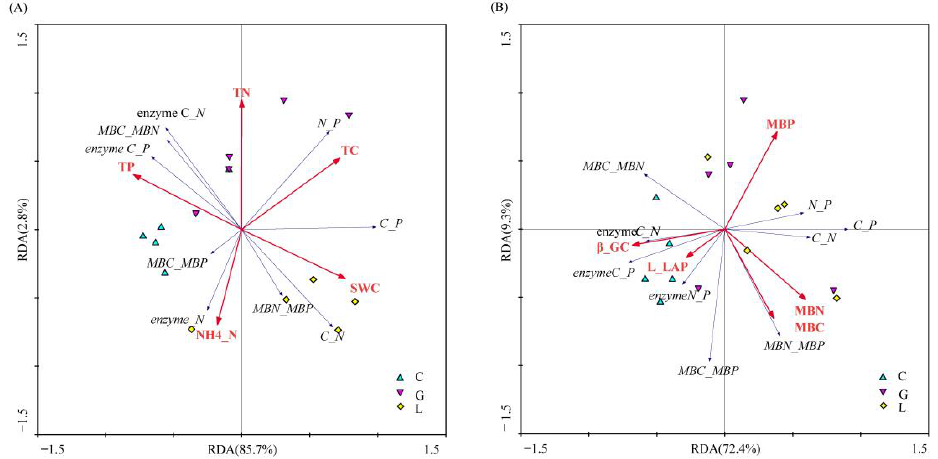
Figure 3. Redundancy analysis of the stoichiometric ratios of soil nutrients ( A ), microbial nutrients and soil extracellular enzyme activities ( B ) of three planting coverts.